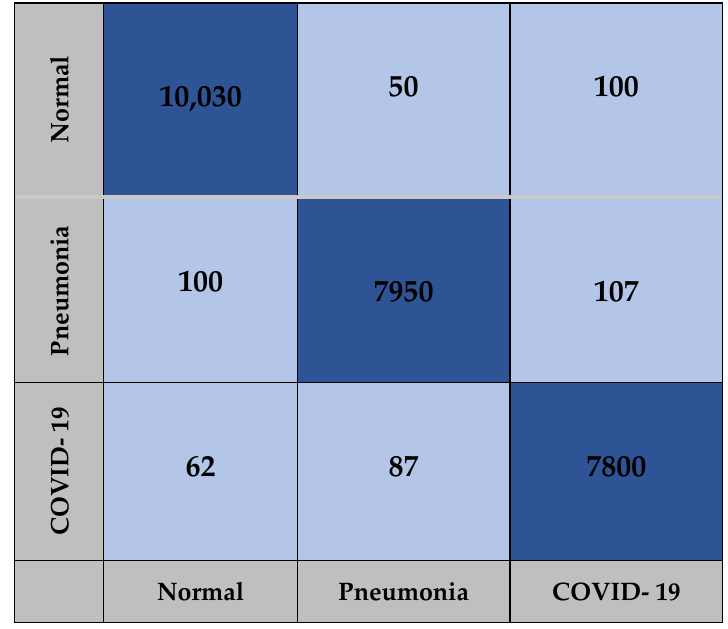
Figure 10. Confusion matrix for Xception model.